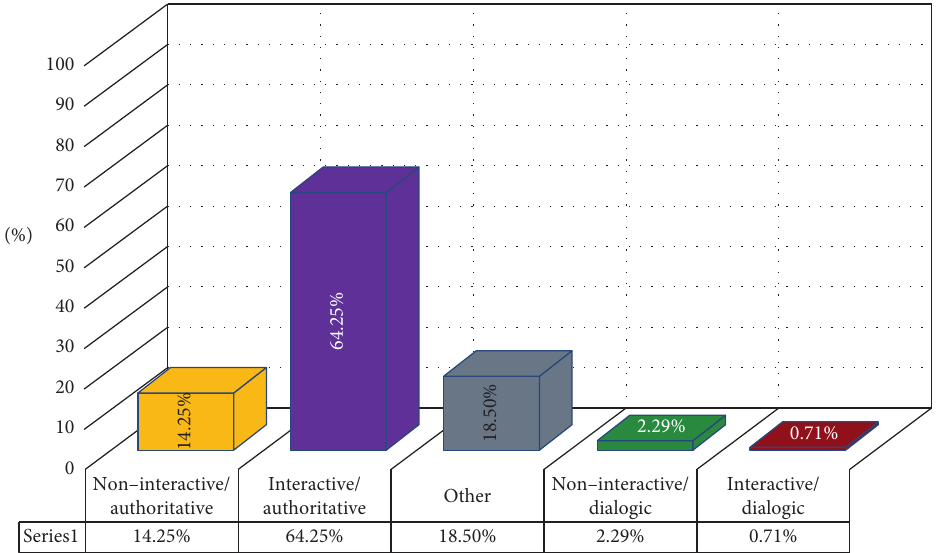
Figure 4: 1 st action plan—percentages of communicative approach types used by